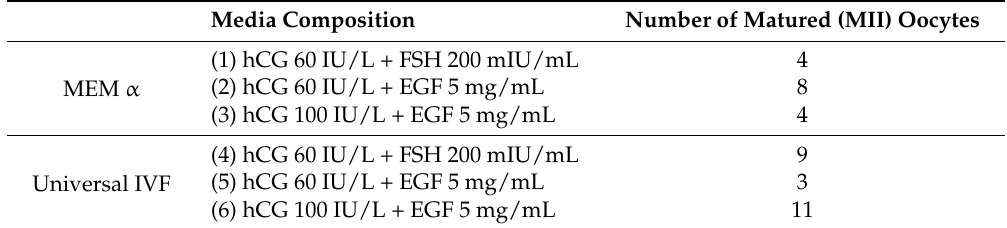
Table 1. Comparison of maturation rate according to media conditions for in vitro maturation (IVM) of marmoset oocytes. MII: metaphase II.